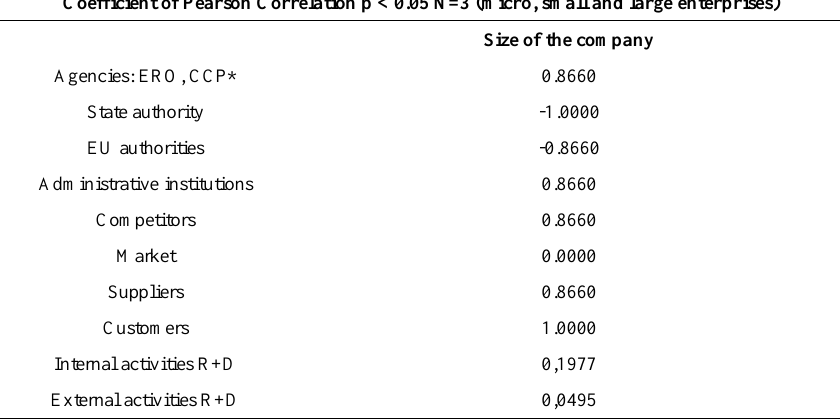
Table 5. Pearson Correlation